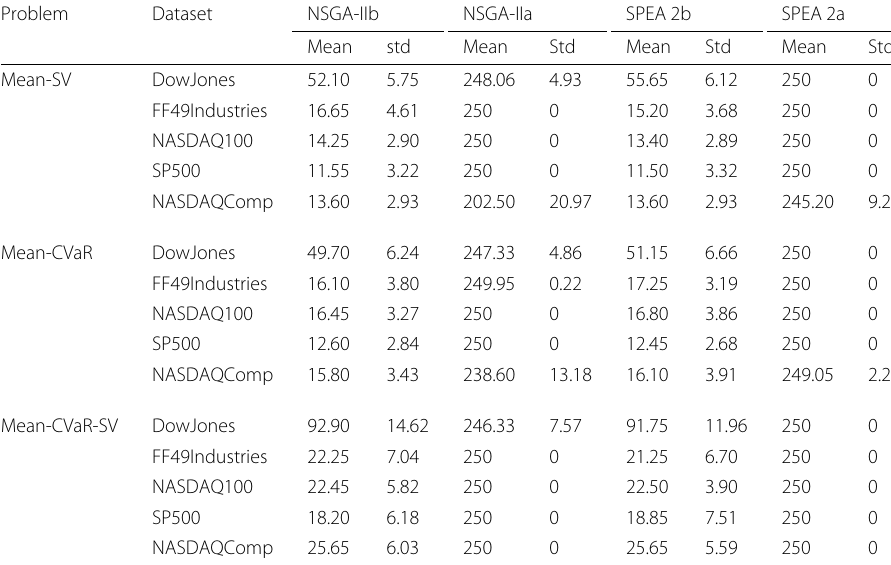
Table 6 Average number of nondominated solutions in the approximated Pareto front (Mean) with the corresponding standard deviation (Std) for each algorithm Problem Dataset